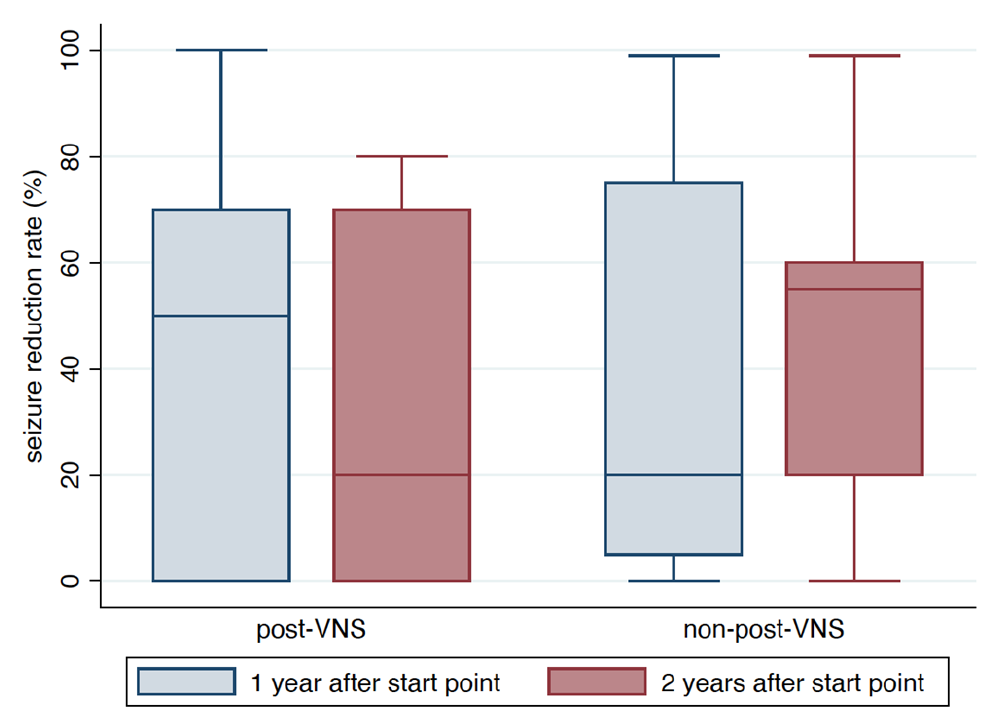
Figure 2. Histogram illustrating the frequency of achieving responder status (≥50% reduction in seizure frequency) at 1 year after start point was 53.85% in the post - VNS group and 12.5% in the non-post-VNS group (blue, p = 0.017, Fisher’s exact test). The frequency of achieving responder sta- tus at 2 years after the start point was 41.67% in the post - VNS group and 27.78% in the non -post- VNS group (red, p = 0.461, Fisher’s exact test).